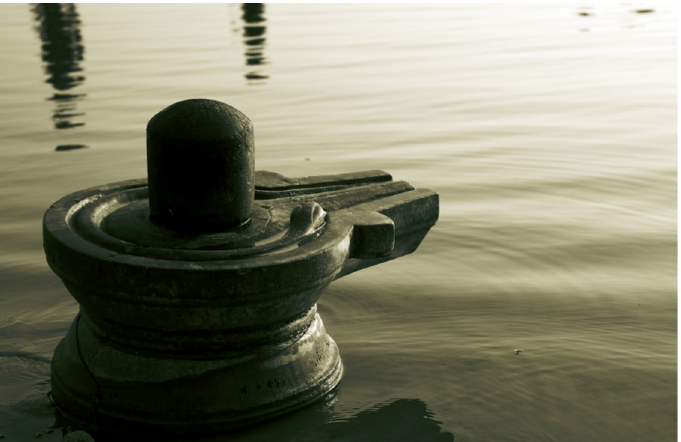
Figure 4. Depicted here is the classic Ś iva Li ṅ ga (phallus), where Ś iva, the ideal experiencer, is within and emerging from the experience of the yoni (vulva) that is Ś akti (picture by pphl, Canva ).